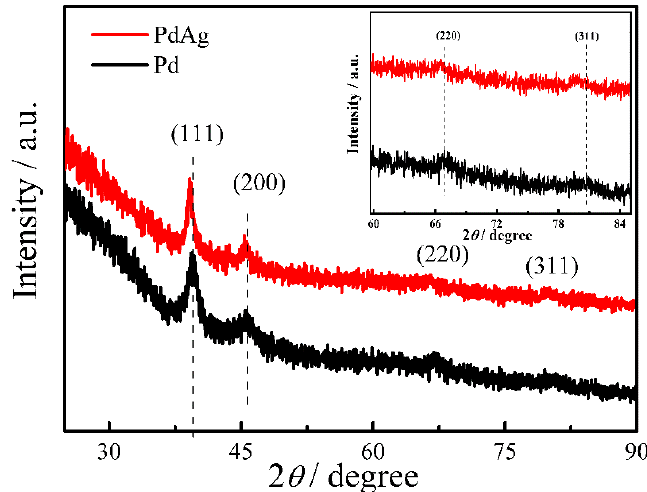
Figure 3. XRD (X ‐ ray diffraction) patterns of as ‐ synthesized PdAg and Pd catalysts.